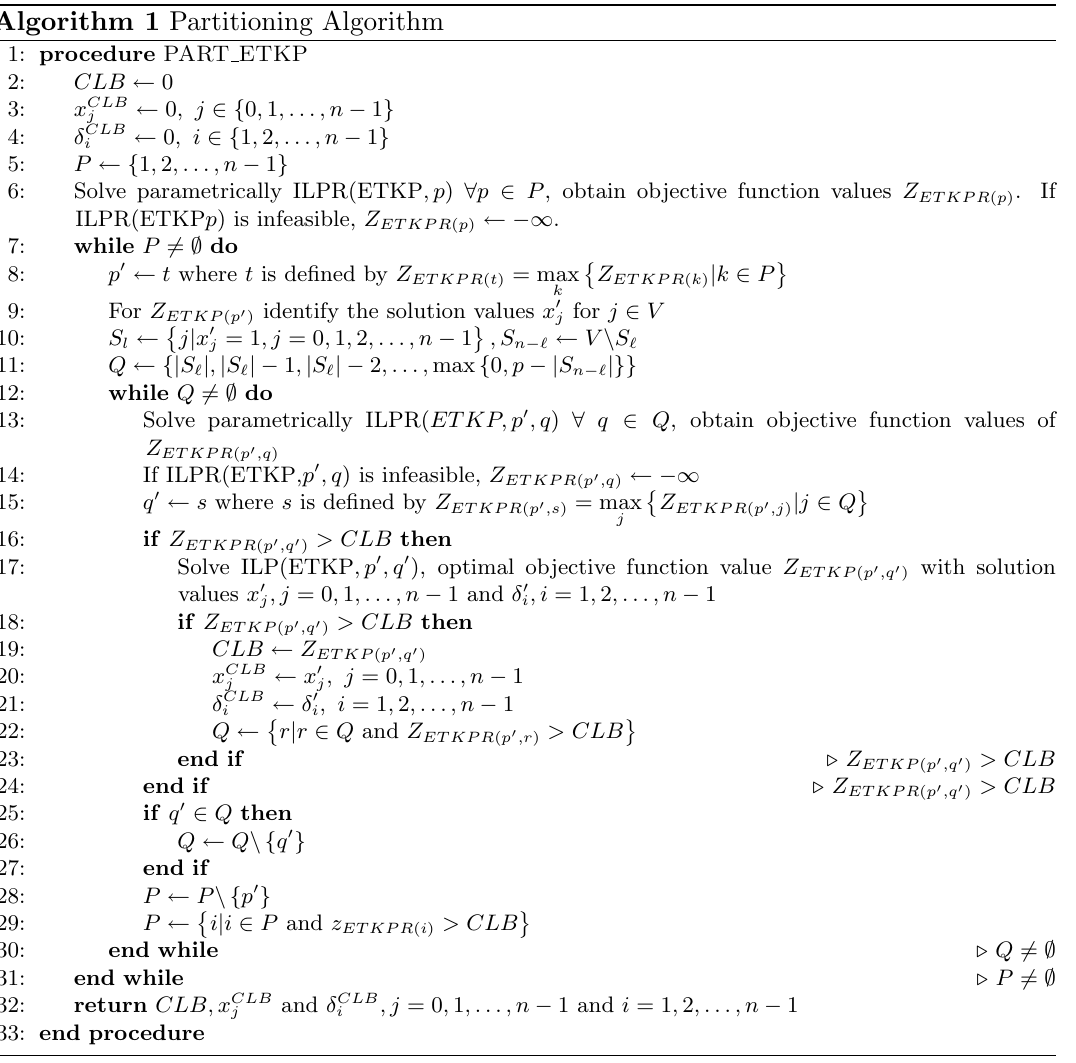
Algorithm 1 Partitioning